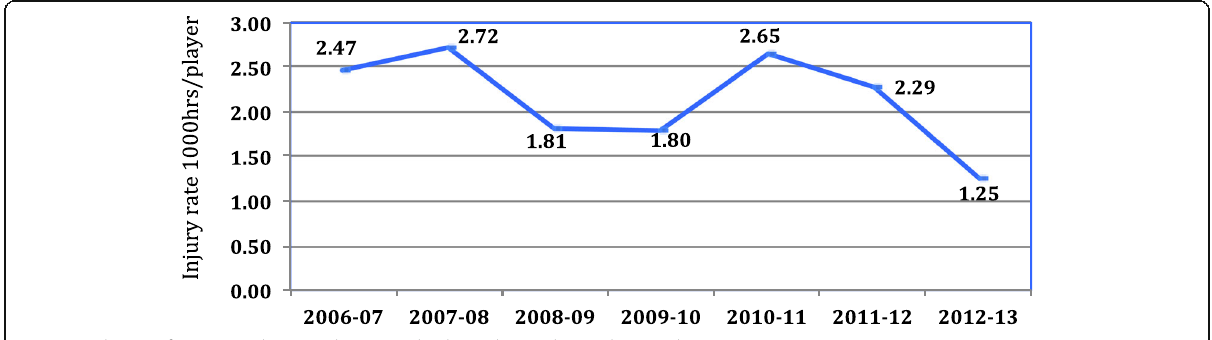
Fig. 1 Evolution of Injury incidence with TL 1000 h/player during the study